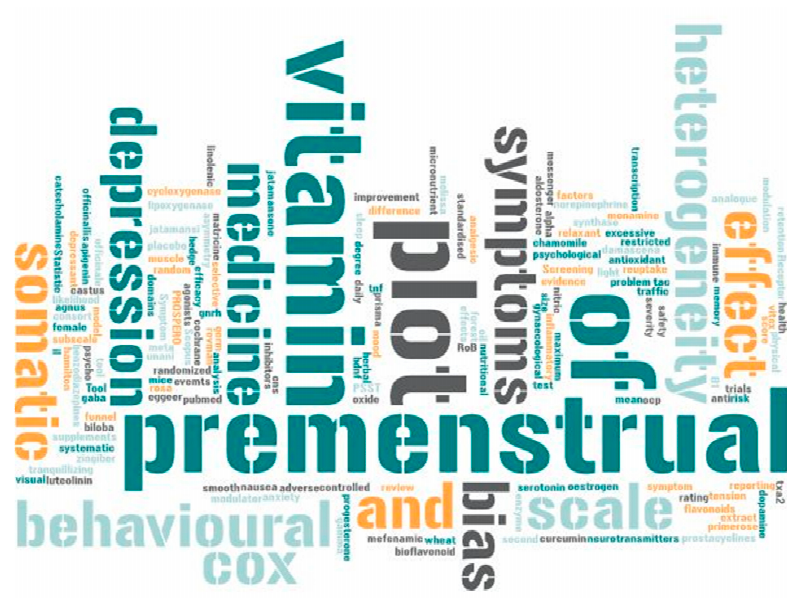
Figure 15. Word clouds of the present study for the collection of the closest terms.